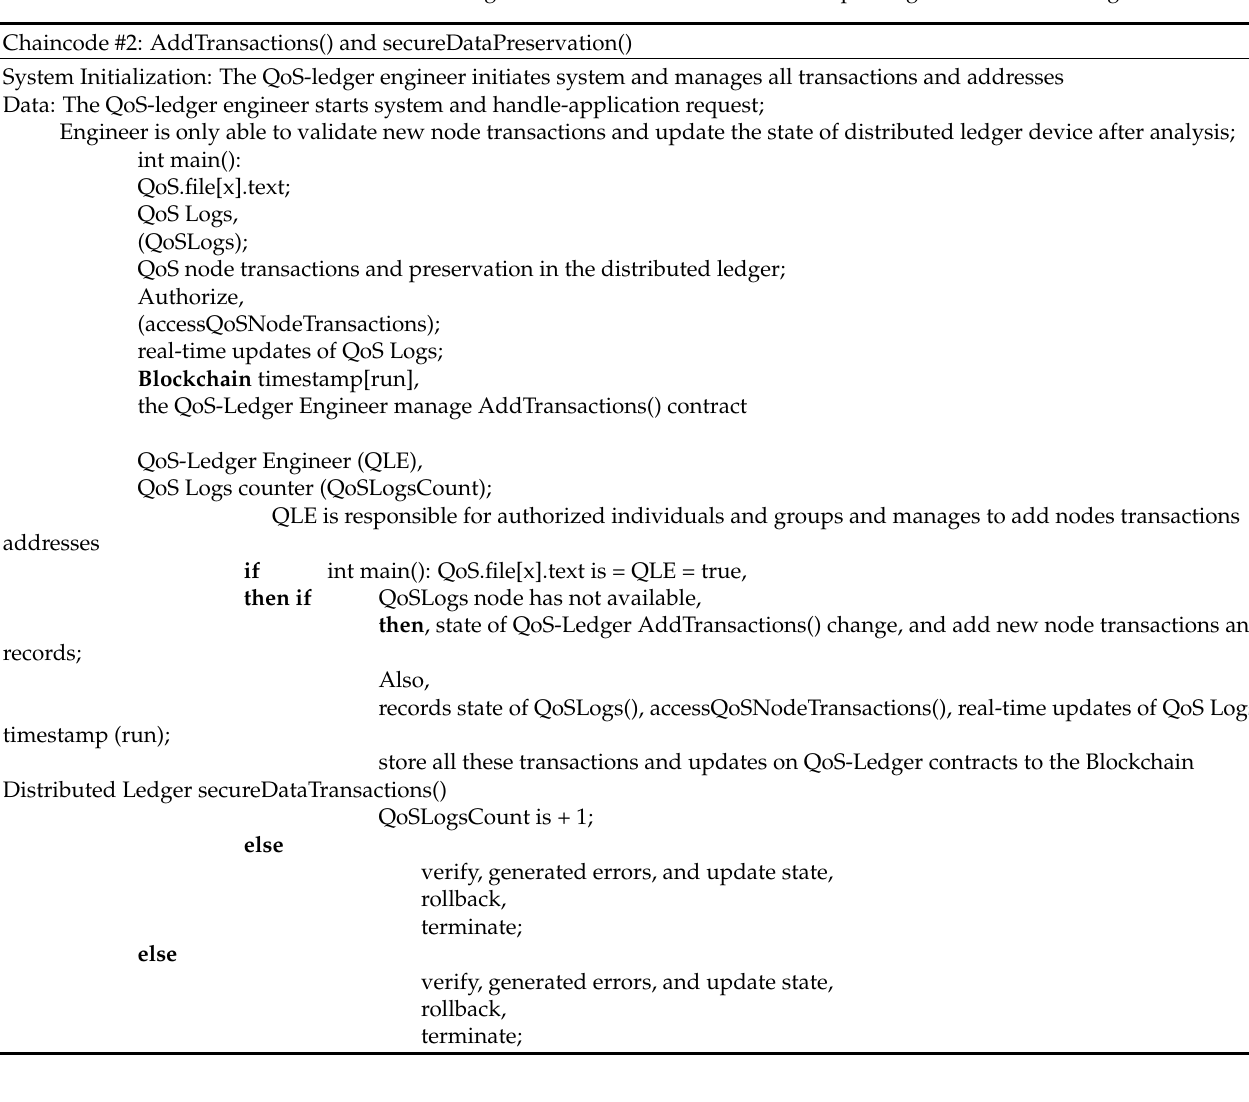
Table 3. Smart contract-2 for adding new healthcare transactions and updating the distributed